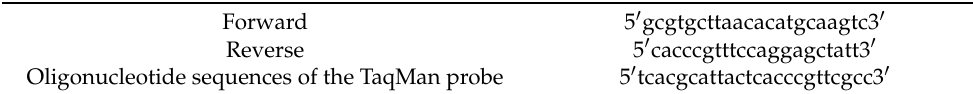
Table 1. DNA primers used for the Bifidobacterium spp. identification.